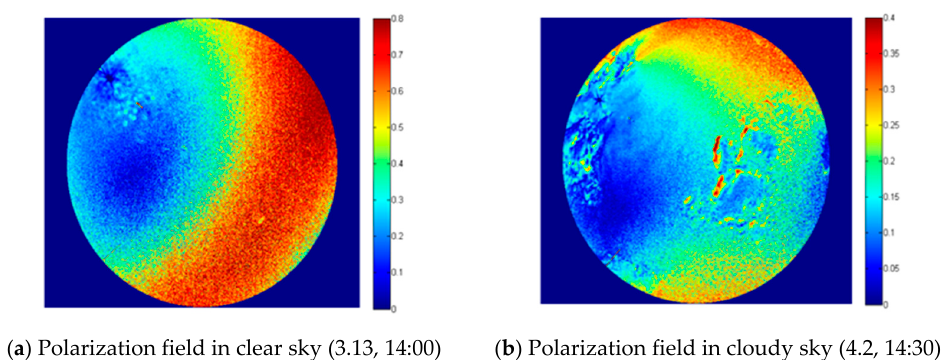
Figure 5. Skylight polarization in different weather conditions.